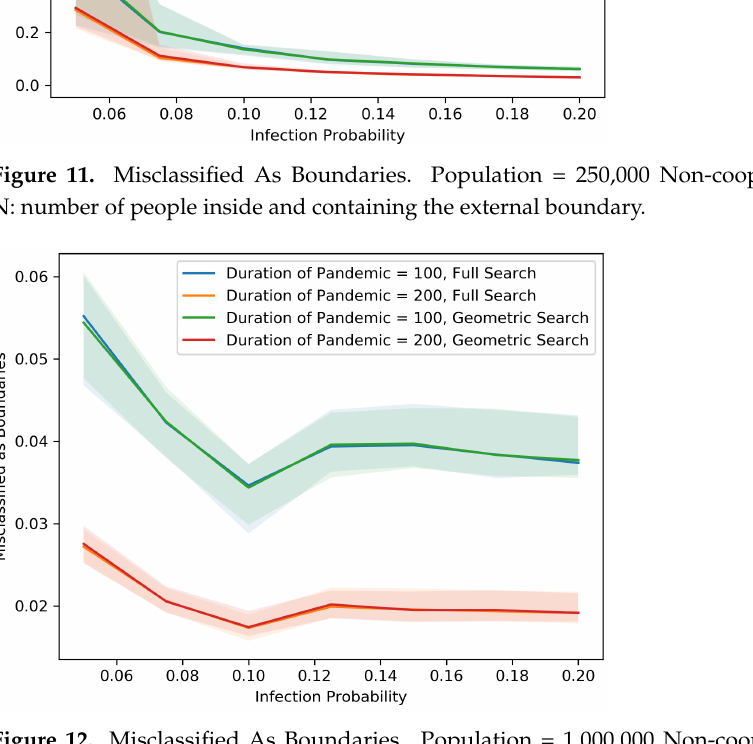
Figure 12. Misclassified As Boundaries. Population = 1,000,000 Non-cooperative Rate = 0.333. N: number of people inside and containing the external